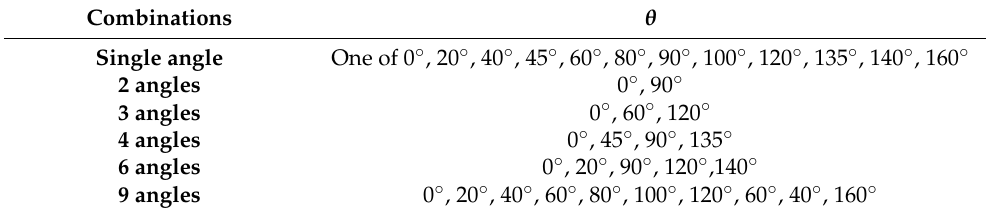
Table 3. Detecting Area-1 using different laser scanning combinations.